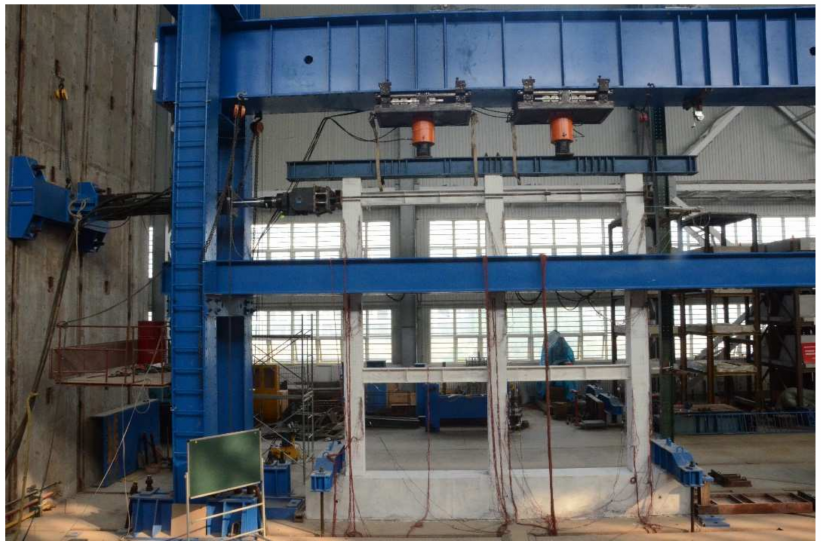
Figure 3. Test loading